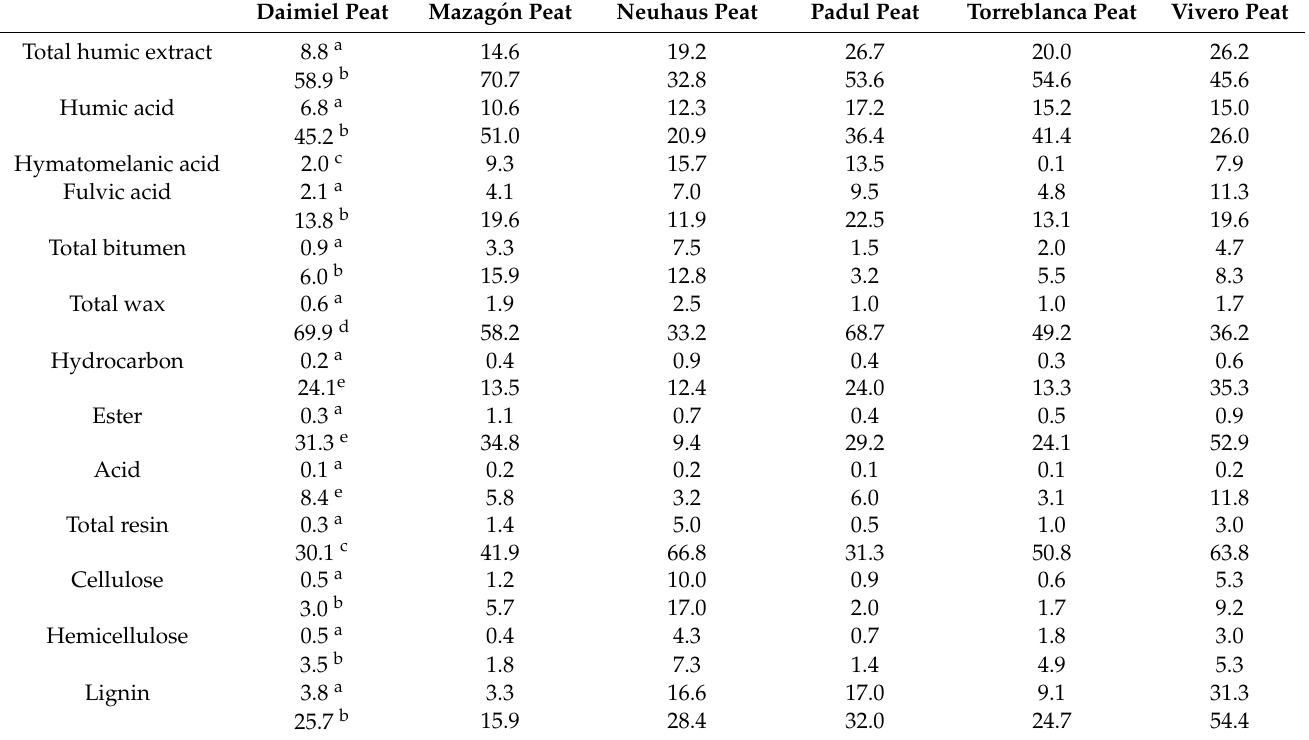
Table 2. Major organic fractions in